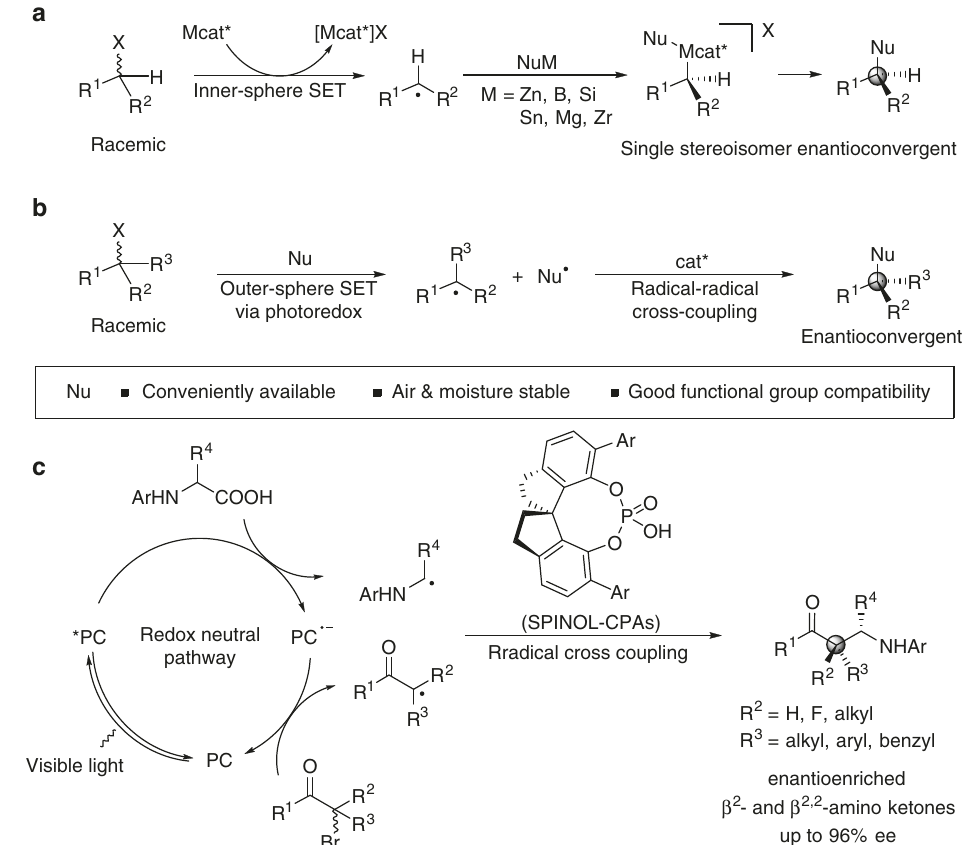
Fig. 1 Strategies for catalytic asymmetric radical-based substitution reactions of simple alkyl halides. a Bimetallic protocol (known). b Radical coupling under visible light-induced photoredox catalysis for enantioconvergent substitution of alkyl halides (design pro fi le). c A dual-catalysis approach to enantioselective radical coupling of N -aryl amino acids to α -bromoketones irradiated by visible light (this work). X halide. PC, photoredox catalyst. SPINOL- CPAs = 1,1 ʹ -spirobiindane-7,7 ʹ -diol (SPINOL)-based spirocyclic chiral phosphoric acids. With the recent rapid development of the fi eld of visible